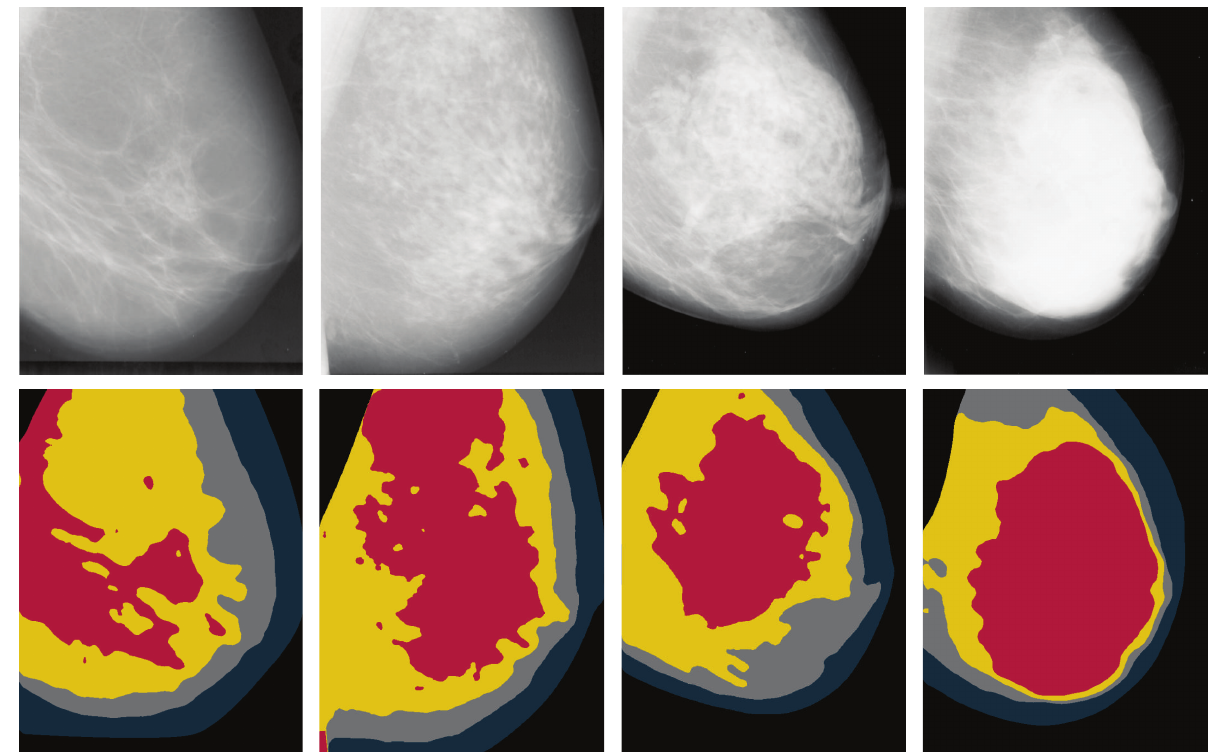
Figure 5: Example mammographic density segmentation. Images (digitised mammograms) from left to right are rated with BI-RADS 1–4, respectively. Fatty, semifatty (e.g., scattered fibroglandular tissue), semidense (e.g., heterogeneous dense tissue), and dense tissue are colour coded as navy, grey, yellow, and red,